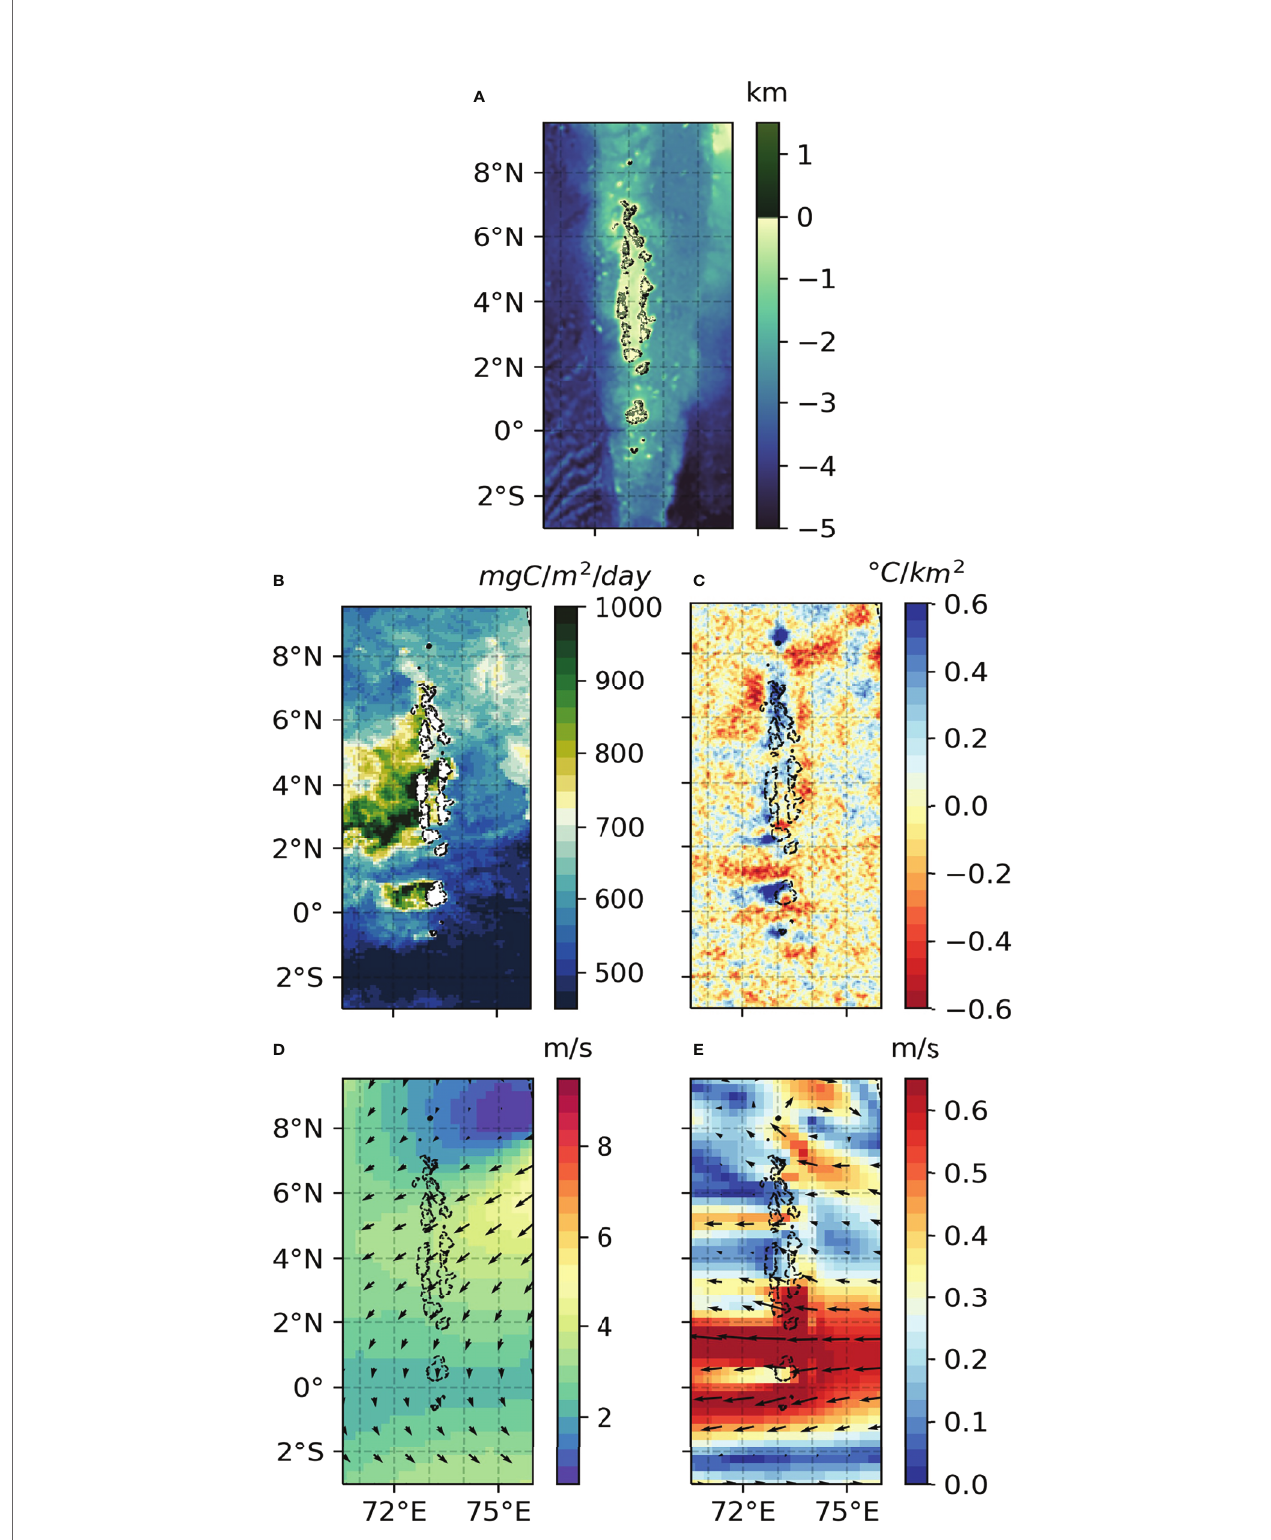
FIGURE 5 | Maldives (A) Topography, (B) NPP, (C) SST Laplacian, (D) Wind Speed, (E) SODA3 currents, February 2013. Black dashed line represents the 100 m depth